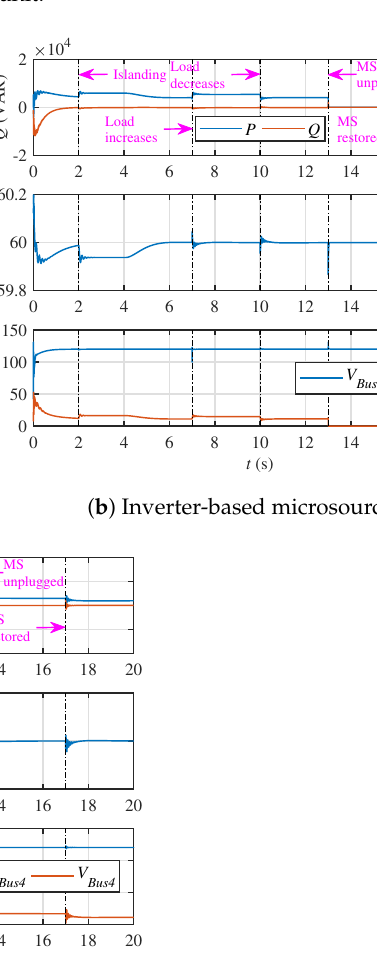
Figure 8. Power sharing output of each DG unit.